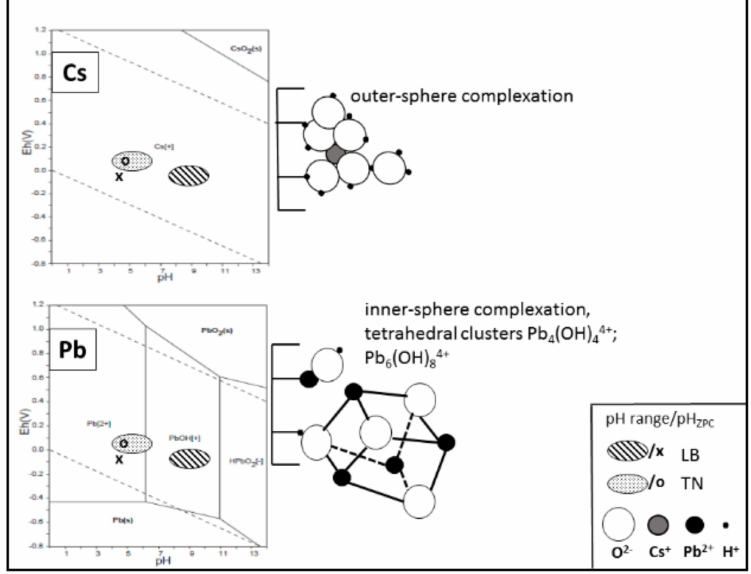
Figure 1. Surface chemistry and expected complexation of Cs + / Pb 2 + in aqueous